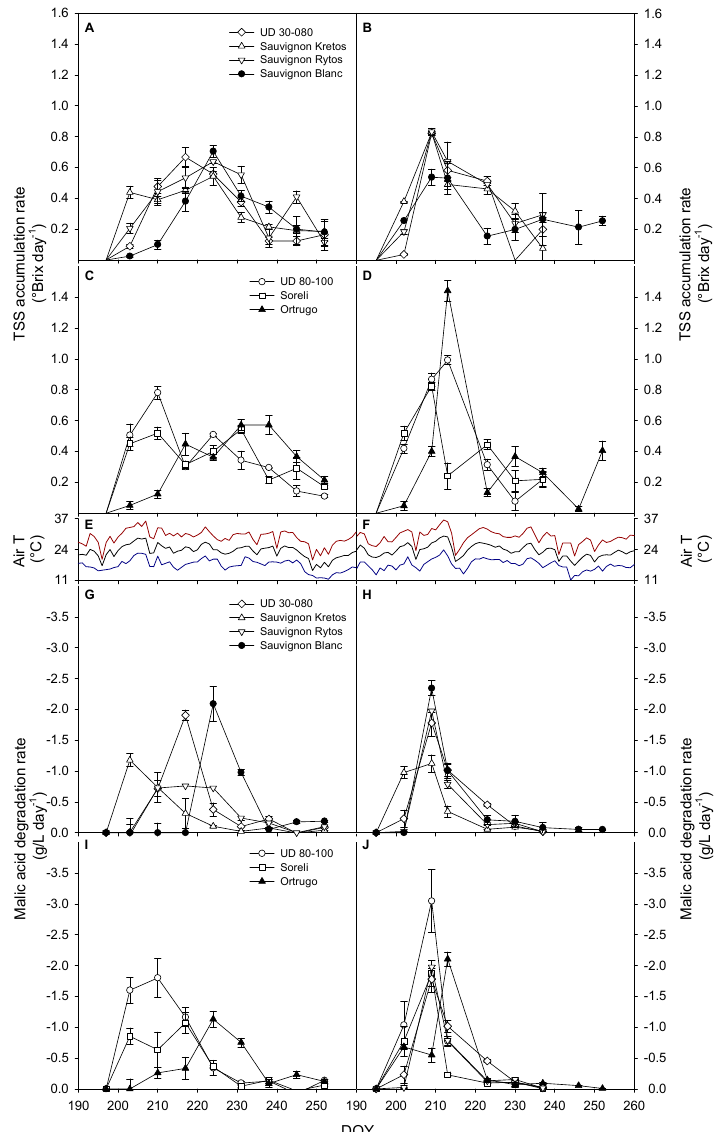
Figure 5. Seasonal evolution of grapes total soluble solids accumulation rates (panels A – D ), malic acid degradation rate (panels G – J ) and minimum temperature (blue line), mean temperature (grey line), and maximum temperatures (red lines) of the period (panels E , F ) in 2019 ( A , C , E , G , I ) and 2020 ( B , D , F , H , J ) for 5 pathogens-resistant varieties (white symbols) and 2 reference V. vinifera cultivars (black symbols). Each point represents the average of three replicates ± SE. DOY = day of year. T = temperature.